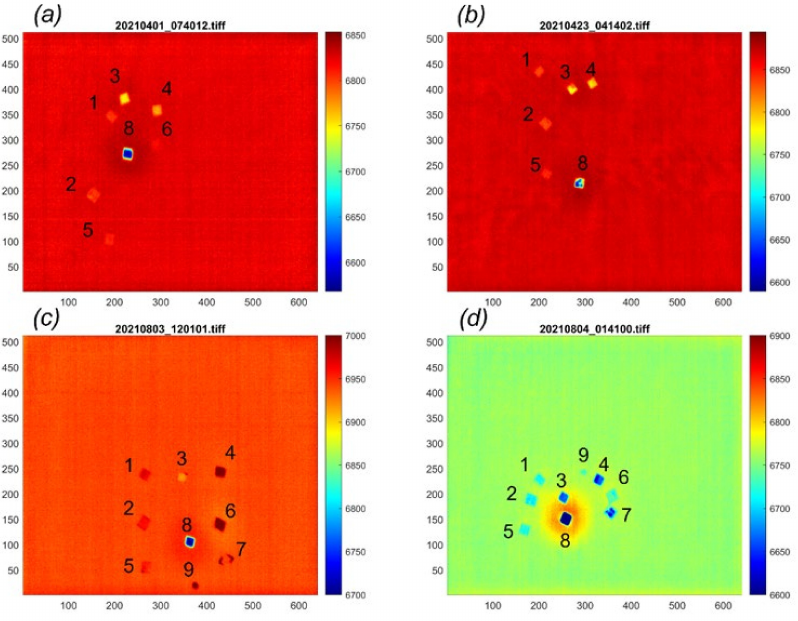
Figure A3. Images as in Figure A2 but seen after flatfield correction, using sigma = 30.